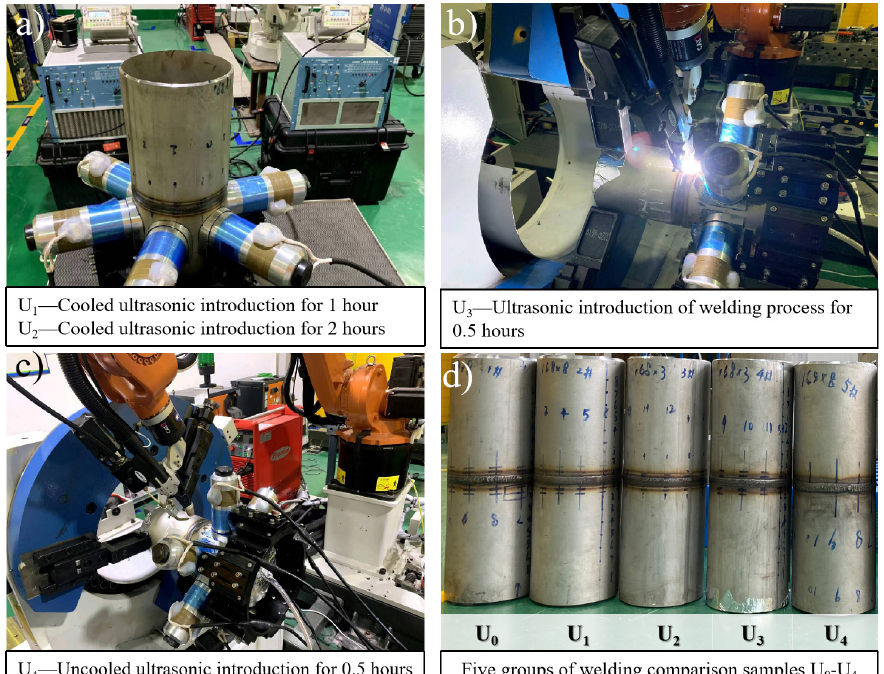
Figure 5. Ultrasonic welding stress regulation process and samples. Table 3. Ultrasonic parameters.